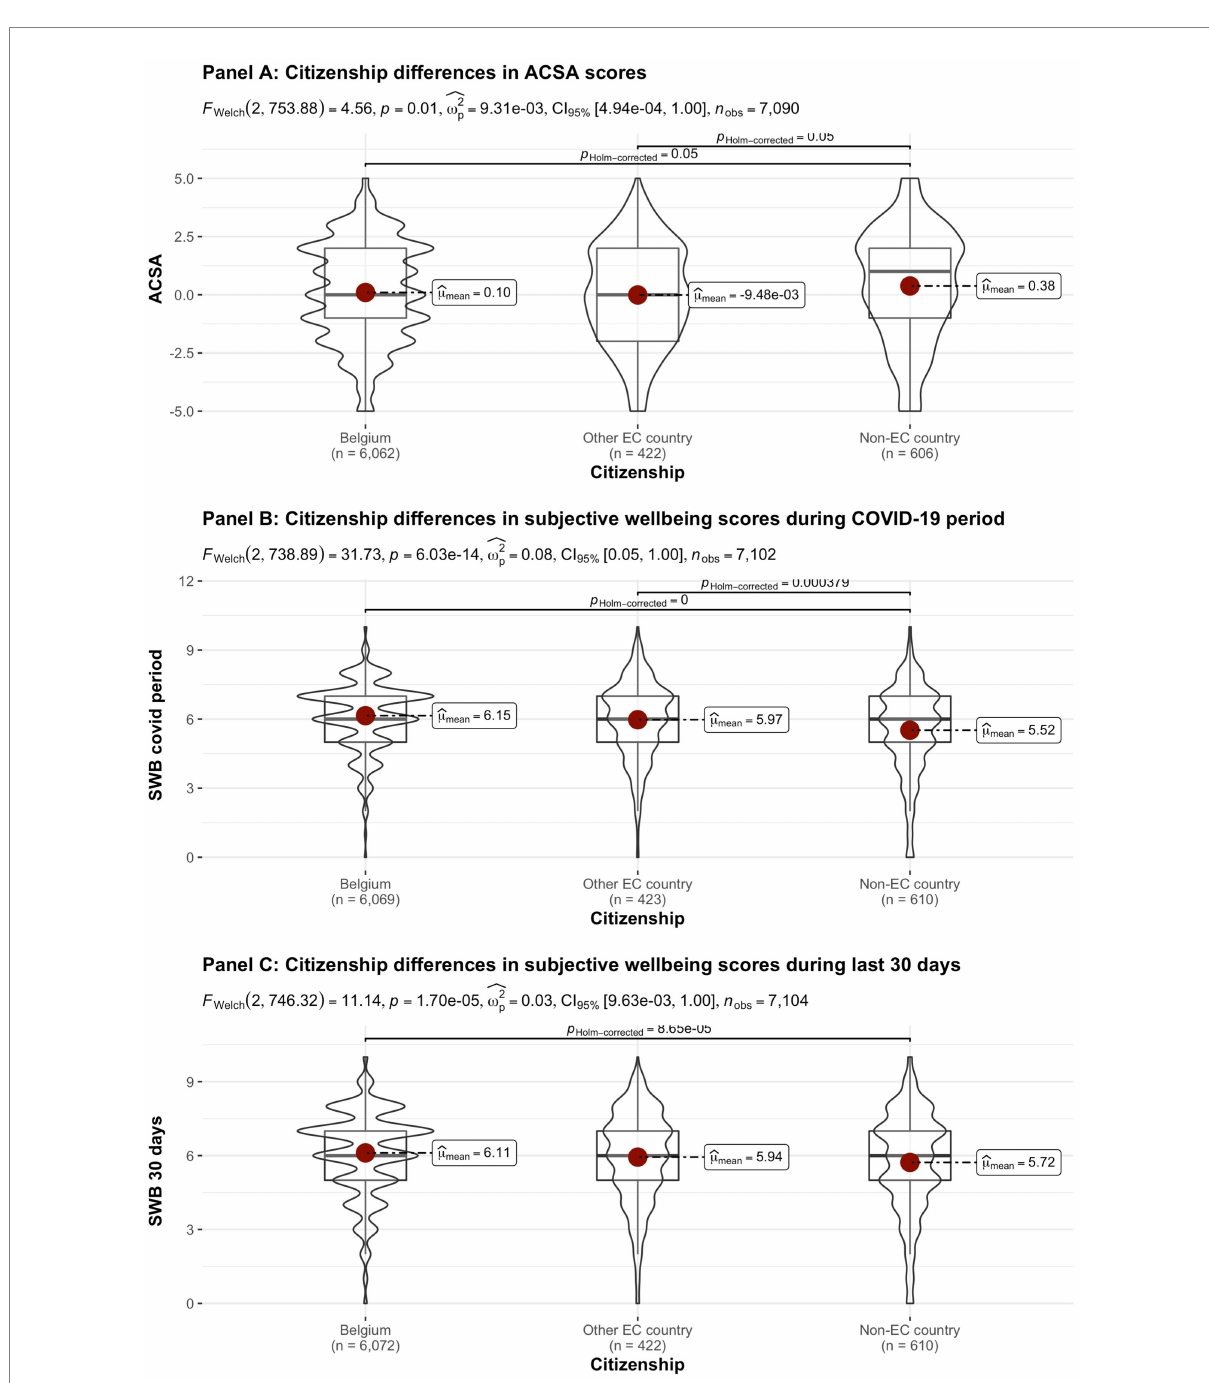
FIGURE 6 Mean ACSA (during the last 2 weeks, on a − 5 to +5 scale) and SWB-scores (during the COVID-19 period, and during the past 30 days, both on a 0–10 scale) comparing student groups during COVID-19 in terms of